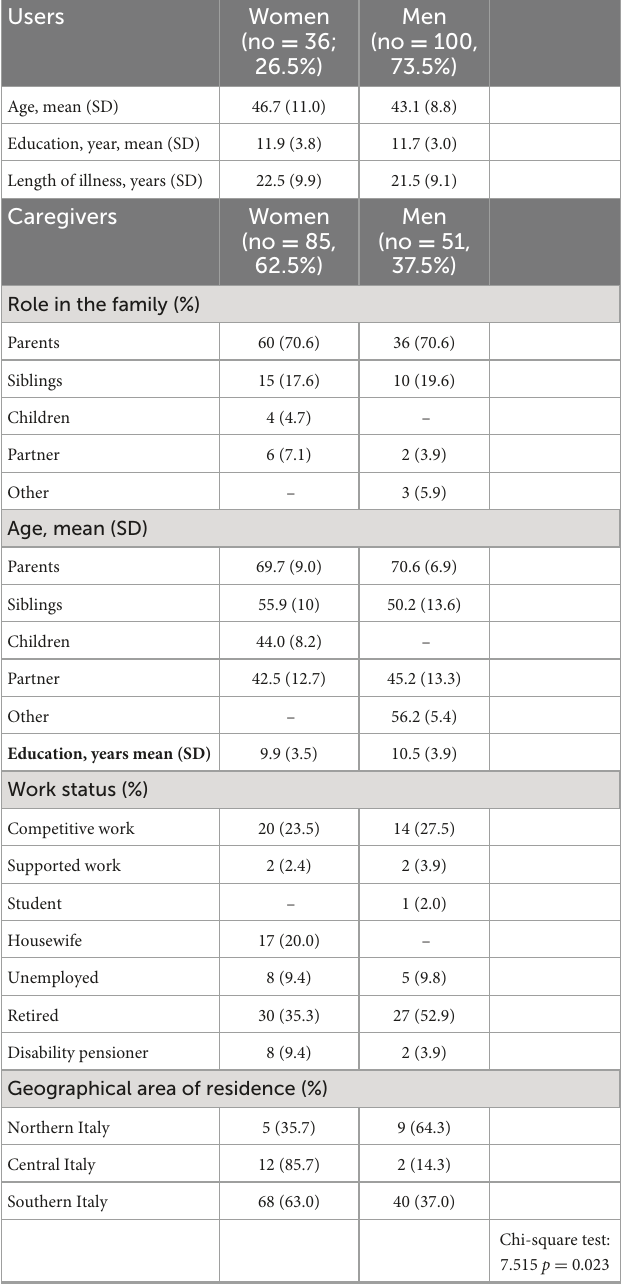
TABLE 1 Demographic characteristics of user and caregiver respondents ( n = 136).